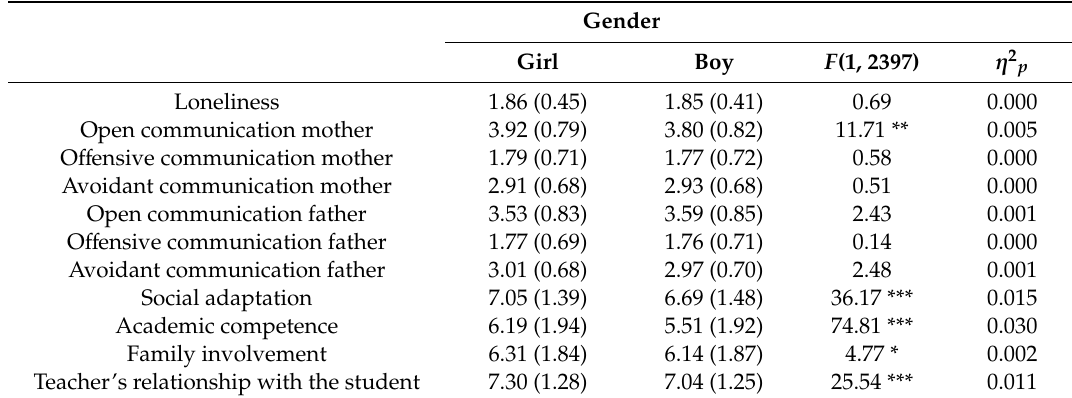
Table 4. Means, standard deviations (SD), and ANOVA results between gender, loneliness, family communication, and school